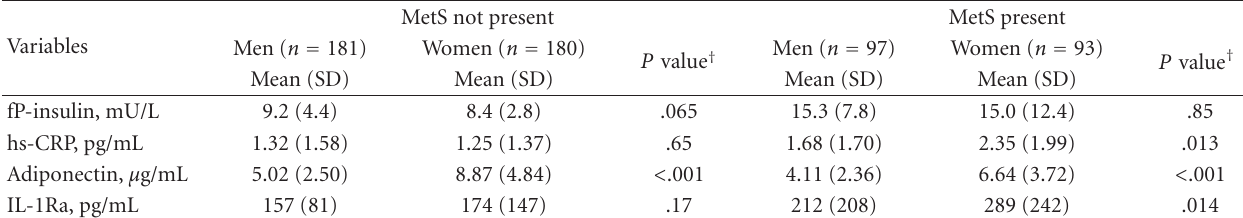
Table 2: Insulin, hs-CRP, and cytokines according to the presence of metabolic